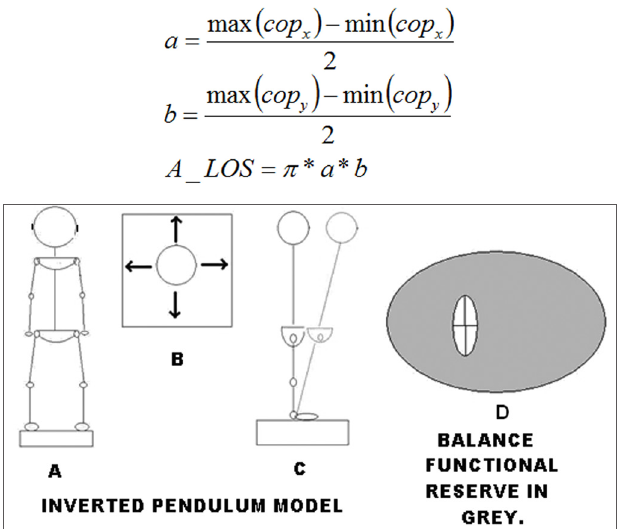
Figure 2. LOS and BFR - Schematic representation of the LOS proce- dures showing subject in quiet stance (A) , direction of the oscillations to test the LOS (B) and the ankle strategies to perform the test (C). The grey area between the LOS and the CE represents the BFR (D).